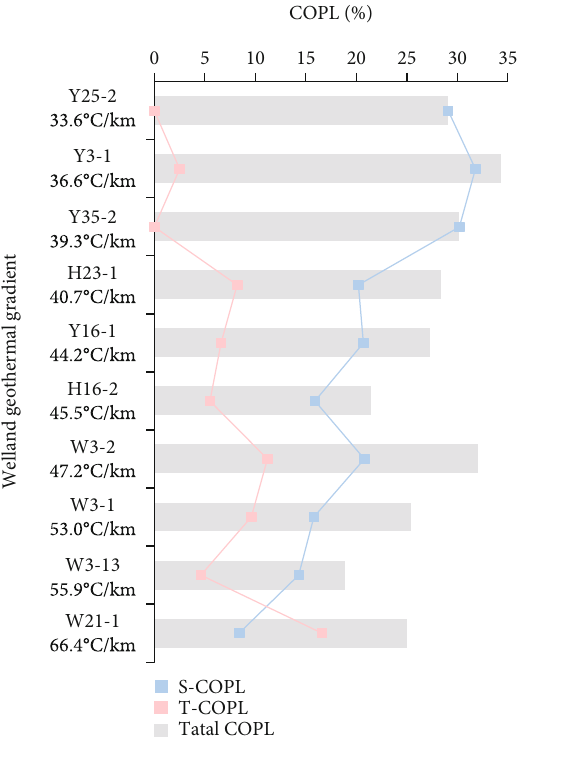
Figure 10: The characteristics of S-COPL and T-COPL in di ff erent geothermal gradient